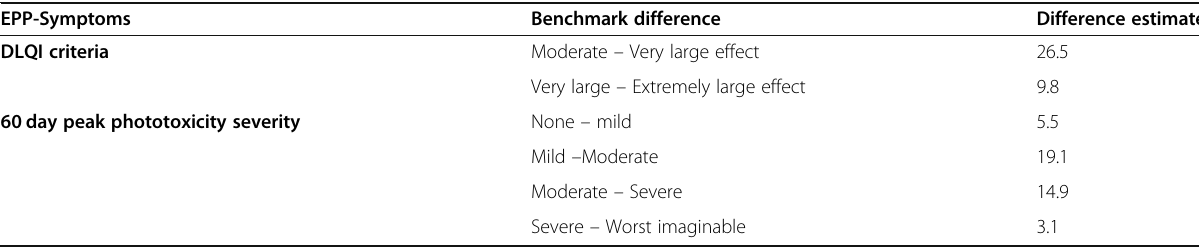
Table 6 Estimates of important difference on EPP-Symptoms scale based on benchmark criteria from DLQI and 60 day peak phototoxicity